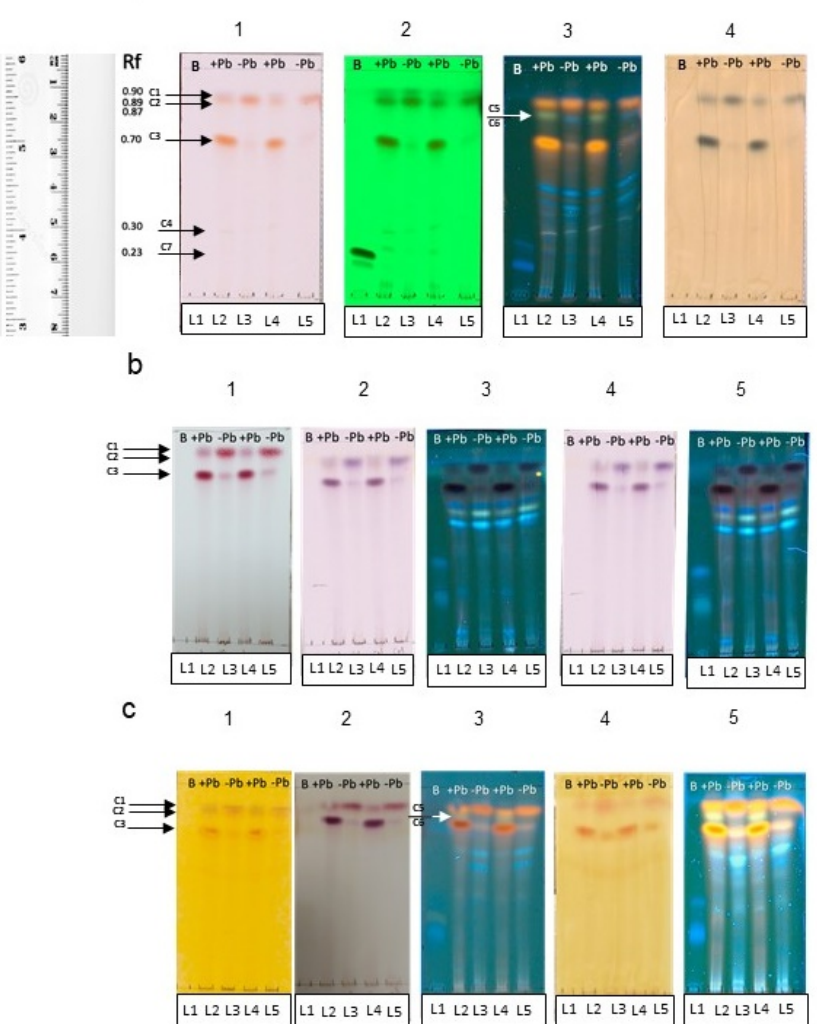
Figure 8. TLC analyses of secondary metabolites produced by strain H17 in presence (+Pb) or absence (-Pb) of lead. Boshnaloside (B) was used as reference standard. Retention front (Rf) of the compounds are indicated. ( a ) General derivatizers. (1) Visible light (Vis), (2) UV-254 nm, (3) UV-365 nm, (4) ferric chloride. ( b ) Detection of phenolics. (1) Sulphuric vainillin; (2) Borntrager-Vis; (3) Borntrager-365 nm; (4) modified Borntrager-Vis; (5) modified Borntrager-365 nm. ( c ) Detection of biogenic amines. (1) Draggendor ff -Vis; (2) Ninhydrin; (3) Ninhydrin-365 nm; (4) Wagner-Vis; (5) Wagner-365 nm. Arrows (C1–C7) denote the bands that di ff erentiate the chemical profile of both types of culture